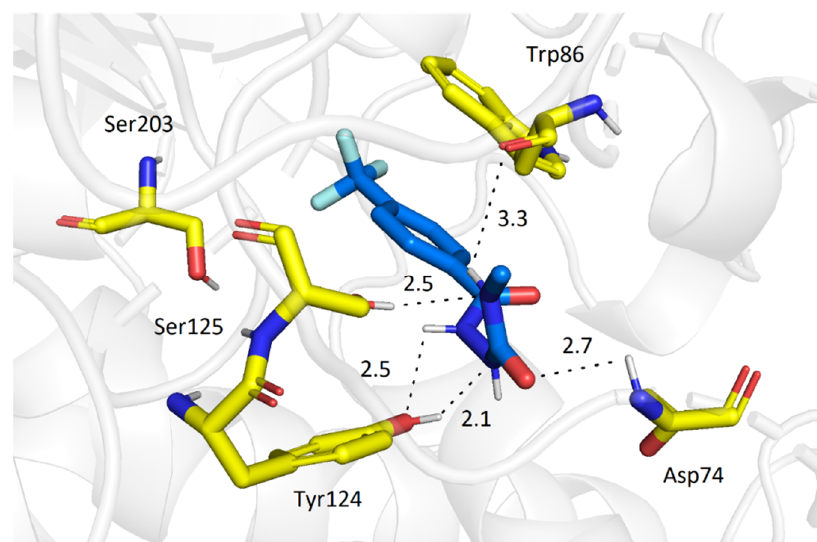
Figure 2. Molecular interactions of 2a (blue) and AChE.